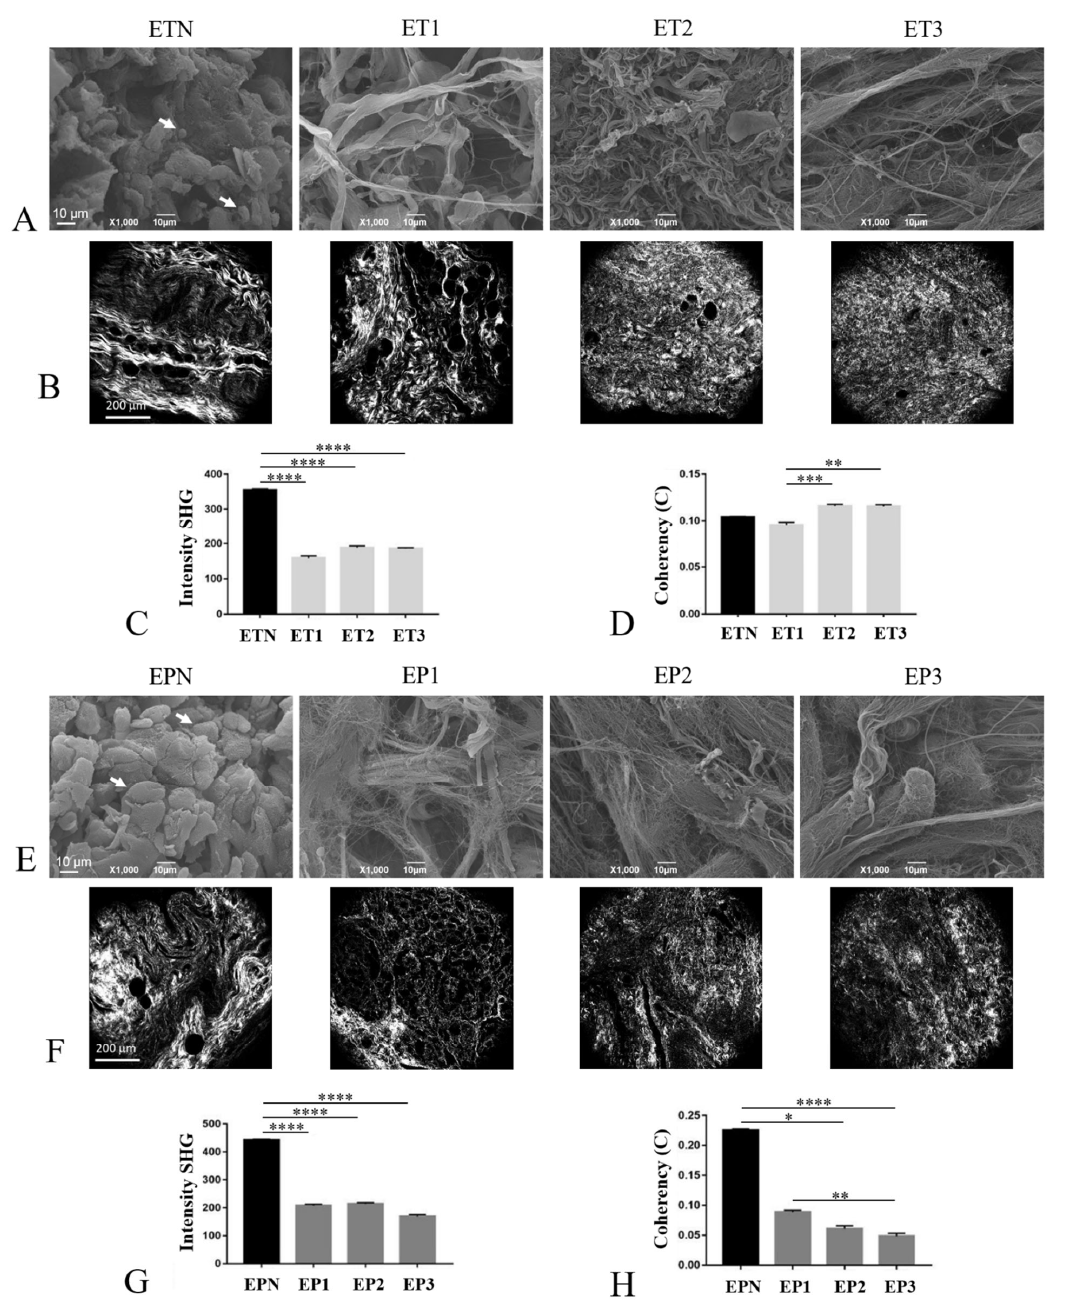
Figure 5. Characterization of collagen component. Collagen investigation in esophageal tubules ( A – D ) and patches (E ‐ H) before (ETN, EPN) and after decellularization with Protocols Nos. 1 (ET1, EP1), 2 (ET2, EP2) and 3 (ET3, EP3). The collagen ultrastructure was analyzed using SEM, and the white arrows show the cells within the ETN and EPN scaffolds ( A , E ). SHG microscopy allowed us to localize specific collagen signals ( B , F ), measure signal intensity ( C , G ) and calculate coherency values for fiber orientation ( D , H ). Scale bars: 10 µ m ( A , E ); 200 µ m ( B , F ) (* p <0.05, ** p <0.01, *** p <0.001, **** p <